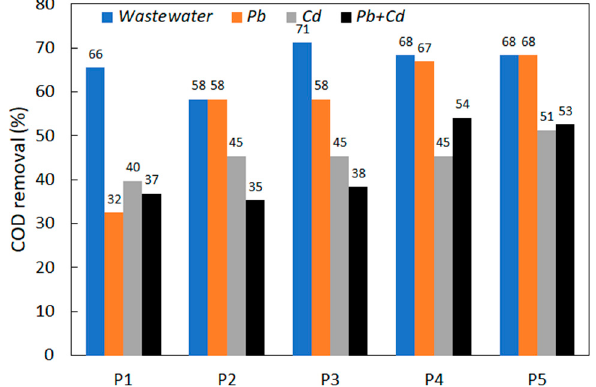
Figure 4. COD removal at the end of the experiment (after 120 h).